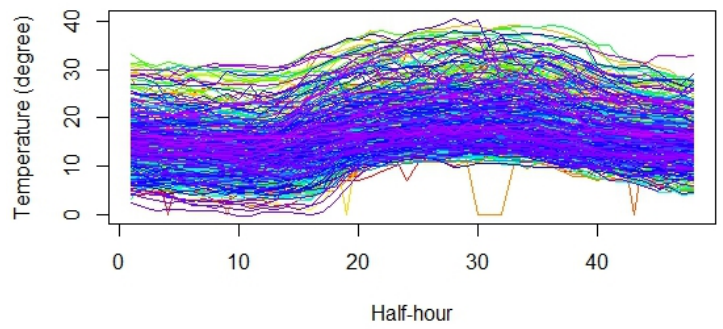
Figure 7. Temperature in Adelaide for